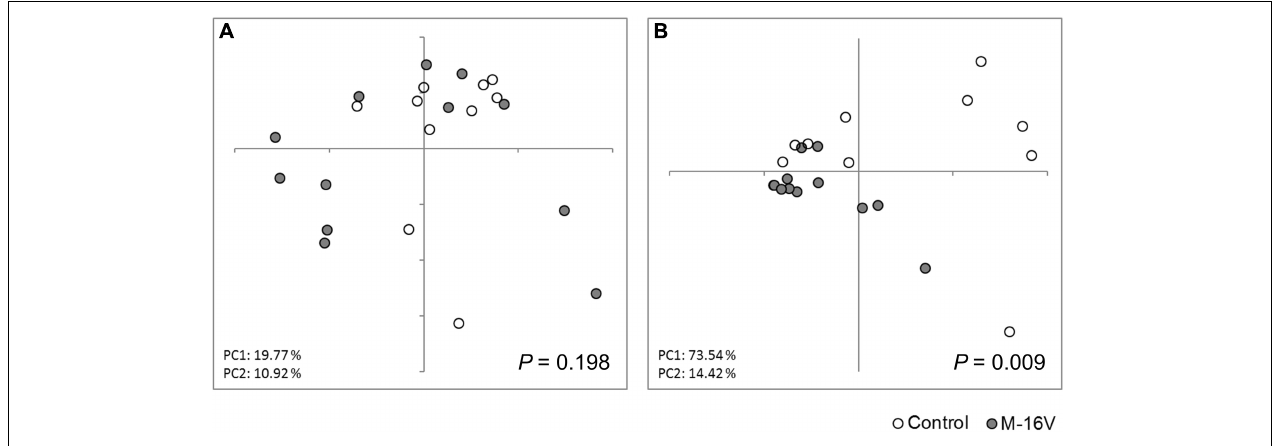
FIGURE 2 | Gut microbiota profiles by PCoA. (A) Unweighted and (B) weighted UniFrac PCoA of the fecal microbiota obtained from subjects in the control group ( n = 10) and the M-16V group ( n = 12). Intergroup differences were analyzed using